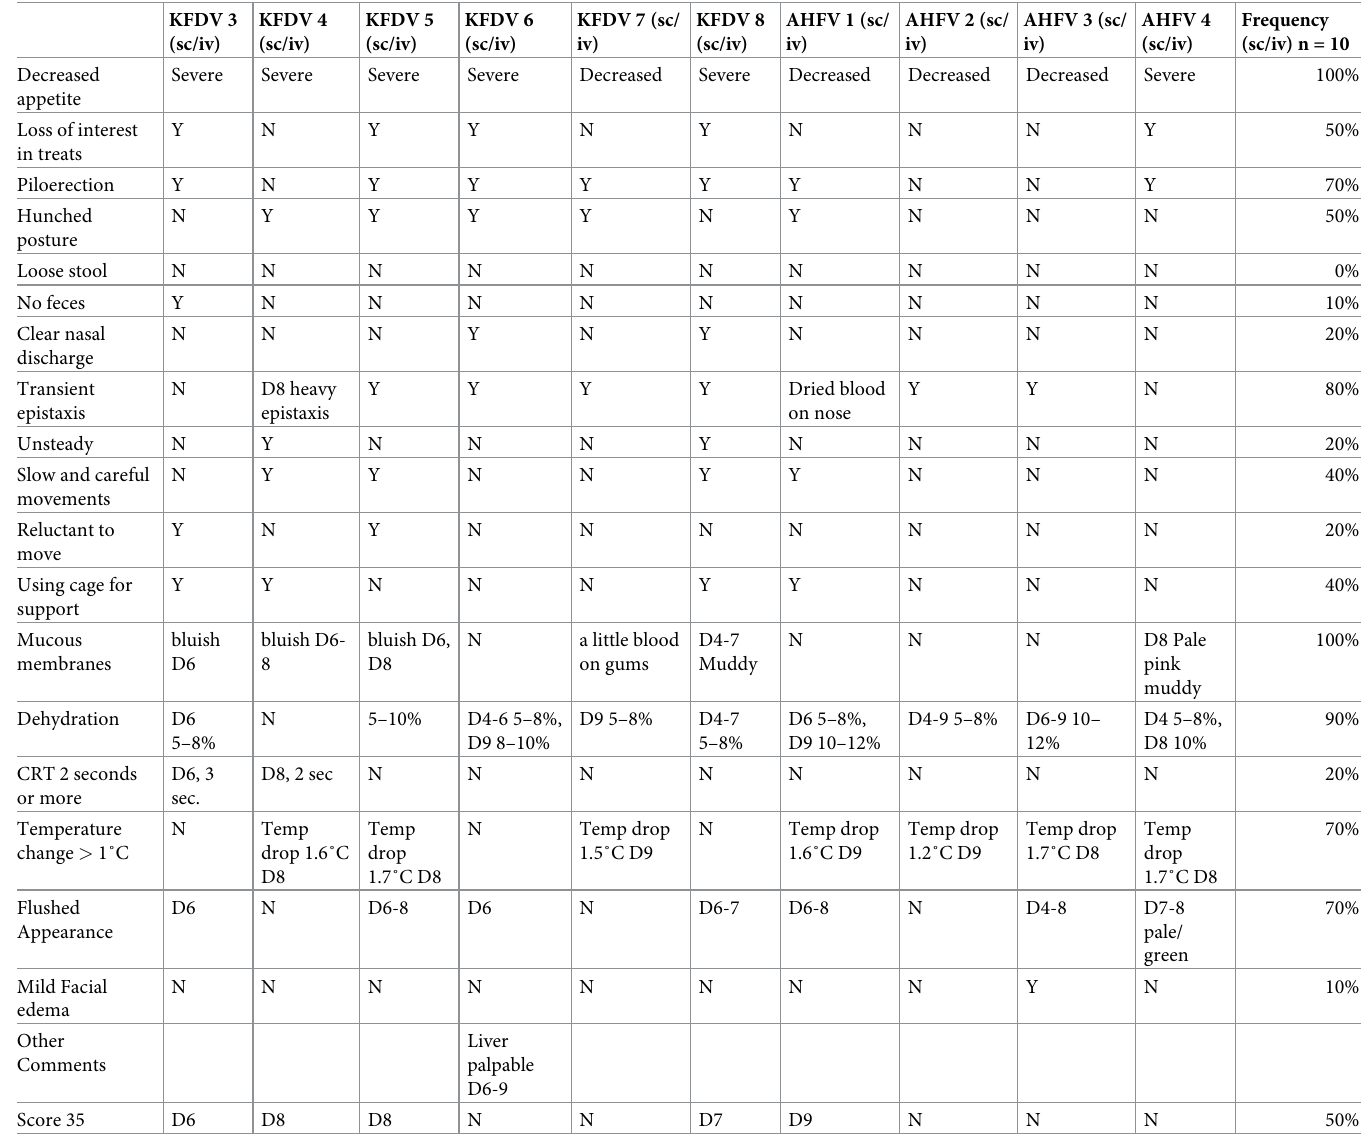
Table 2. KFDV and AHFV clinical observations. Pigtailed macaques were observed for clinical signs following sc/iv inoculation of KFDV or AHFV. Some parameters (mucous membrane color, dehydration, breathing quality, CRT, and temperature) were only measured during exams. The presence or absence of a clinical sign are reported as Y (yes) or N